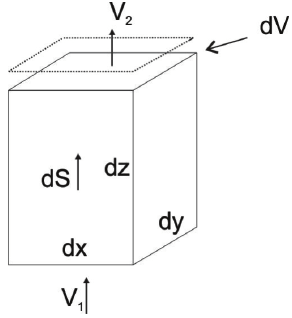
Fig. 1. Elementary volume of saturated